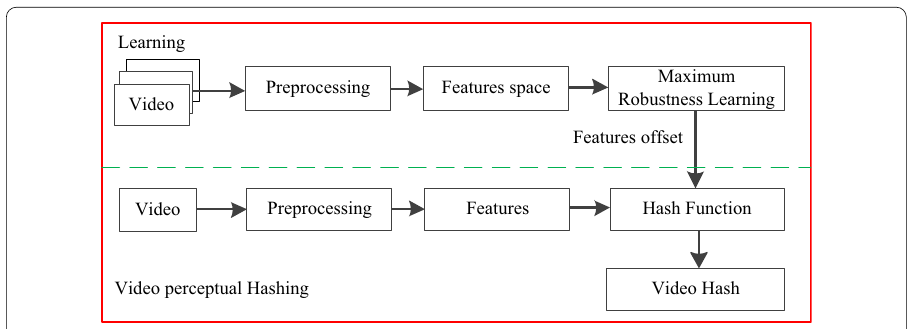
Fig. 2 Block diagram of video perceptual hashing with maximized robustness. In the learning part, video, together with their variants under perceptual content preserving and distorting operations, are preprocessed to form the feature space. The maximum feature offset is learned to be regarded as the maximized robustness. In the hashing part, a particular video is processed to obtain its feature, and the feature is adjusted by the feature offset. Hash function is performed to the feature to generate the final